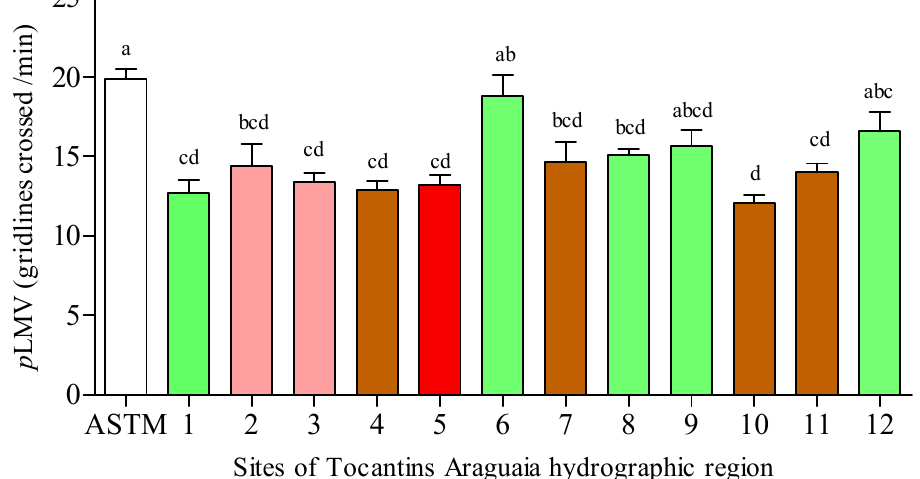
Figure 2. Feeding rate (number of C. xanthus larvae consumed per hour) of G. tigrina after 96 h exposure with water samples from Tocantins-Araguaia Sites Hydrographic Region: Lagoa da Con- fusão (1–3); Formoso do Araguaia (4–6); Porto Nacional (7–9); Gurupi (10–12); Reference (12). A laboratory control with ASTM only was also used to expose planarians. Values represent the mean (± SEM), n = 10. Different letters indicate significant differences between study sites when p < 0.05. Colors used in graph bars are associated with analysis of water performed: very high concen- trations, high concentrations, above acceptable limits, acceptable limit.